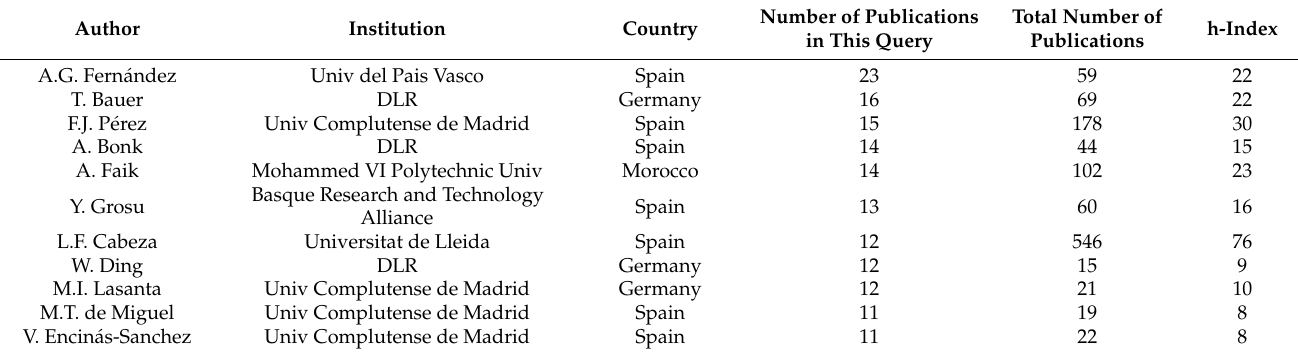
Table 3. Authors with the highest number of